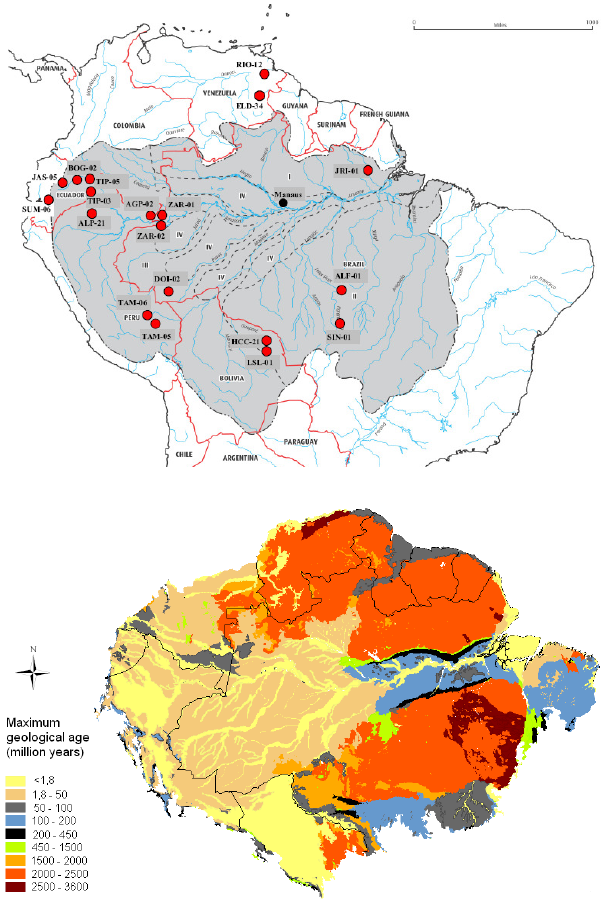
Fig. 1. (a) Division of the Amazon Basin fertility regions accord- ing to Fittkau (1971). (I) Guyana shield; (II) Brazilian shield; (III) Western peripheral area and (IV) Central Amazonia. Study sites depicted in this map relate to soil profiles used as examples in this paper. (b) Maximum geological age for Amazonia (from Schobbenhaus and Bellizzia,